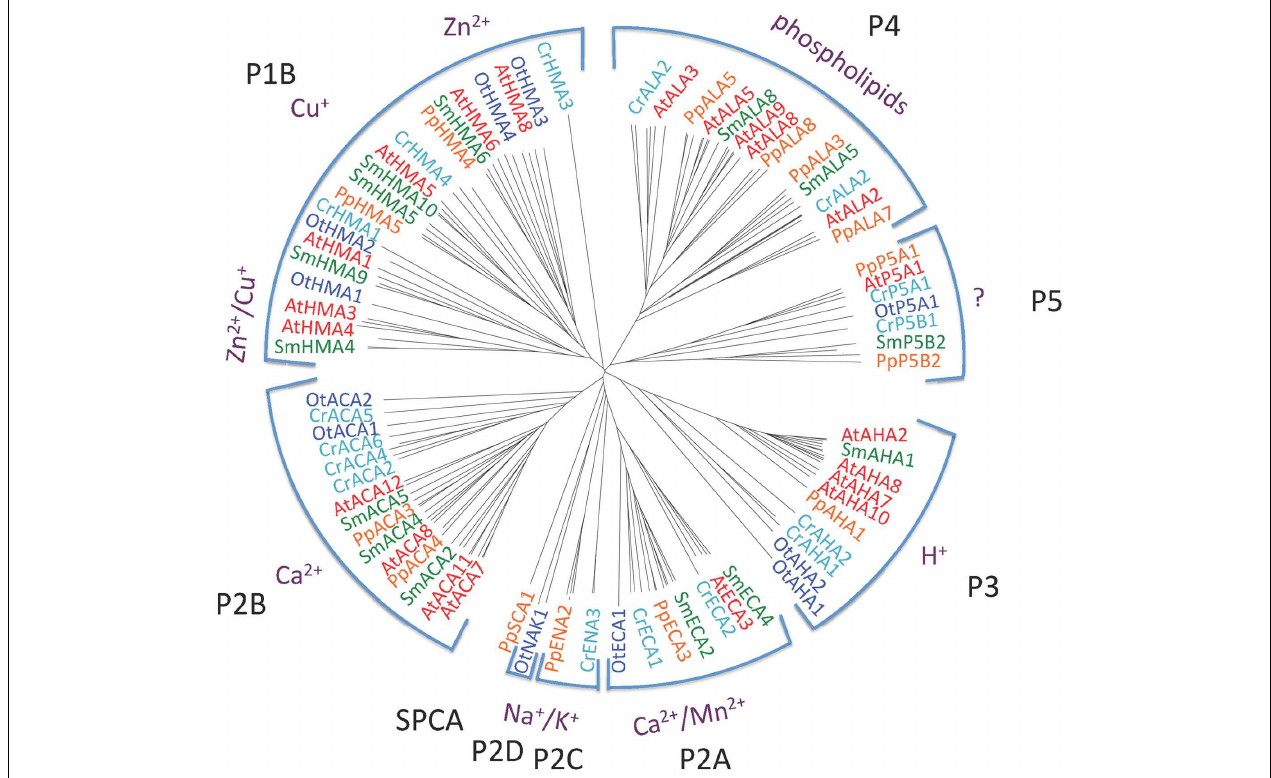
FIGURE 2 | Phylogenetic tree of P-typeATPases analyzed in this study. Not all branches are labeled. Accession numbers for sequences are given in Table 2